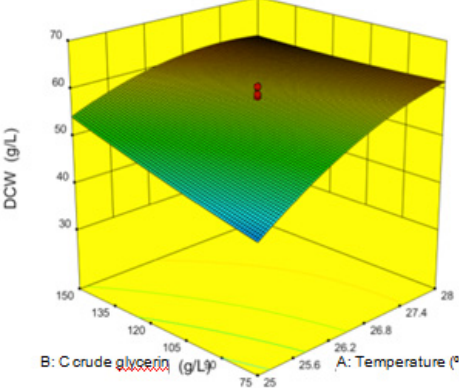
Figure 3. Correlation between the DCW levels and crude glycerin concentration (red points indicate the maximum DCW values).